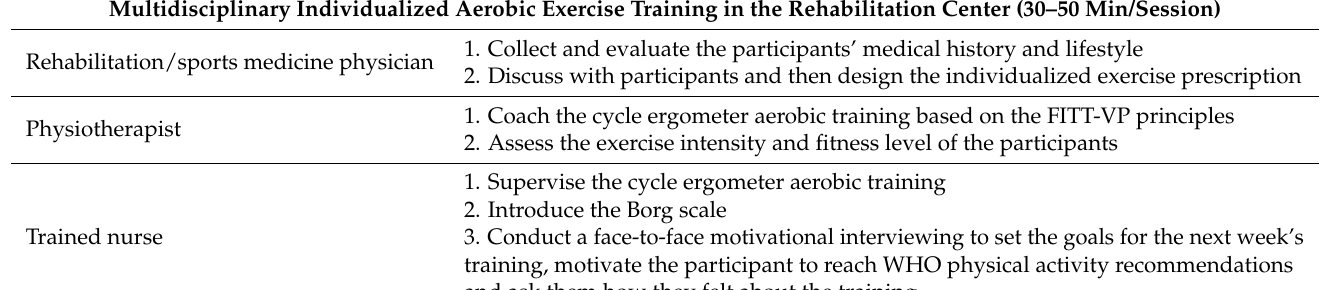
Table 1. 12-week individualized aerobic exercise training combined with telephone-based motivational interviewing content. Multidisciplinary Individualized Aerobic Exercise Training in the Rehabilitation Center (30–50 Min/Session) Rehabilitation/sports medicine